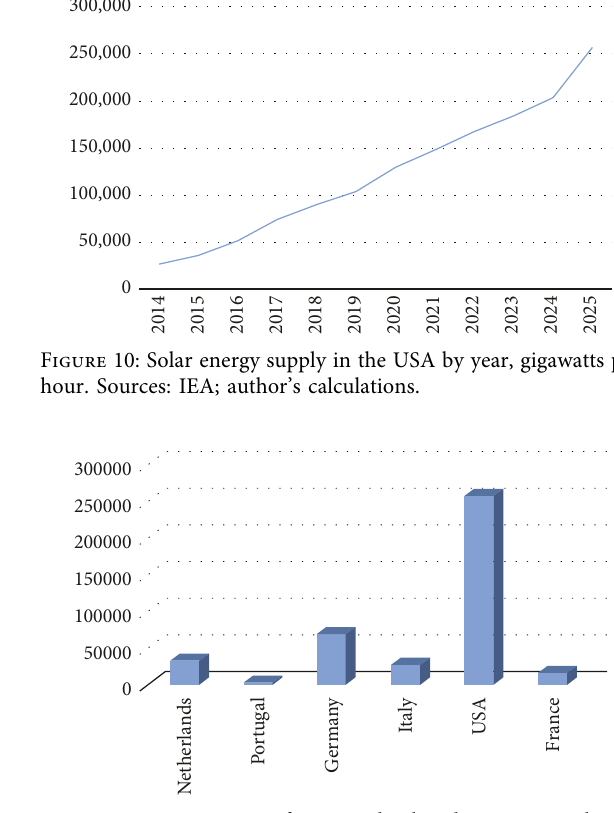
Figure 11: Comparison of projected solar electricity supplies to developed countries in 2025, gigawatts per hour. Source: author’s